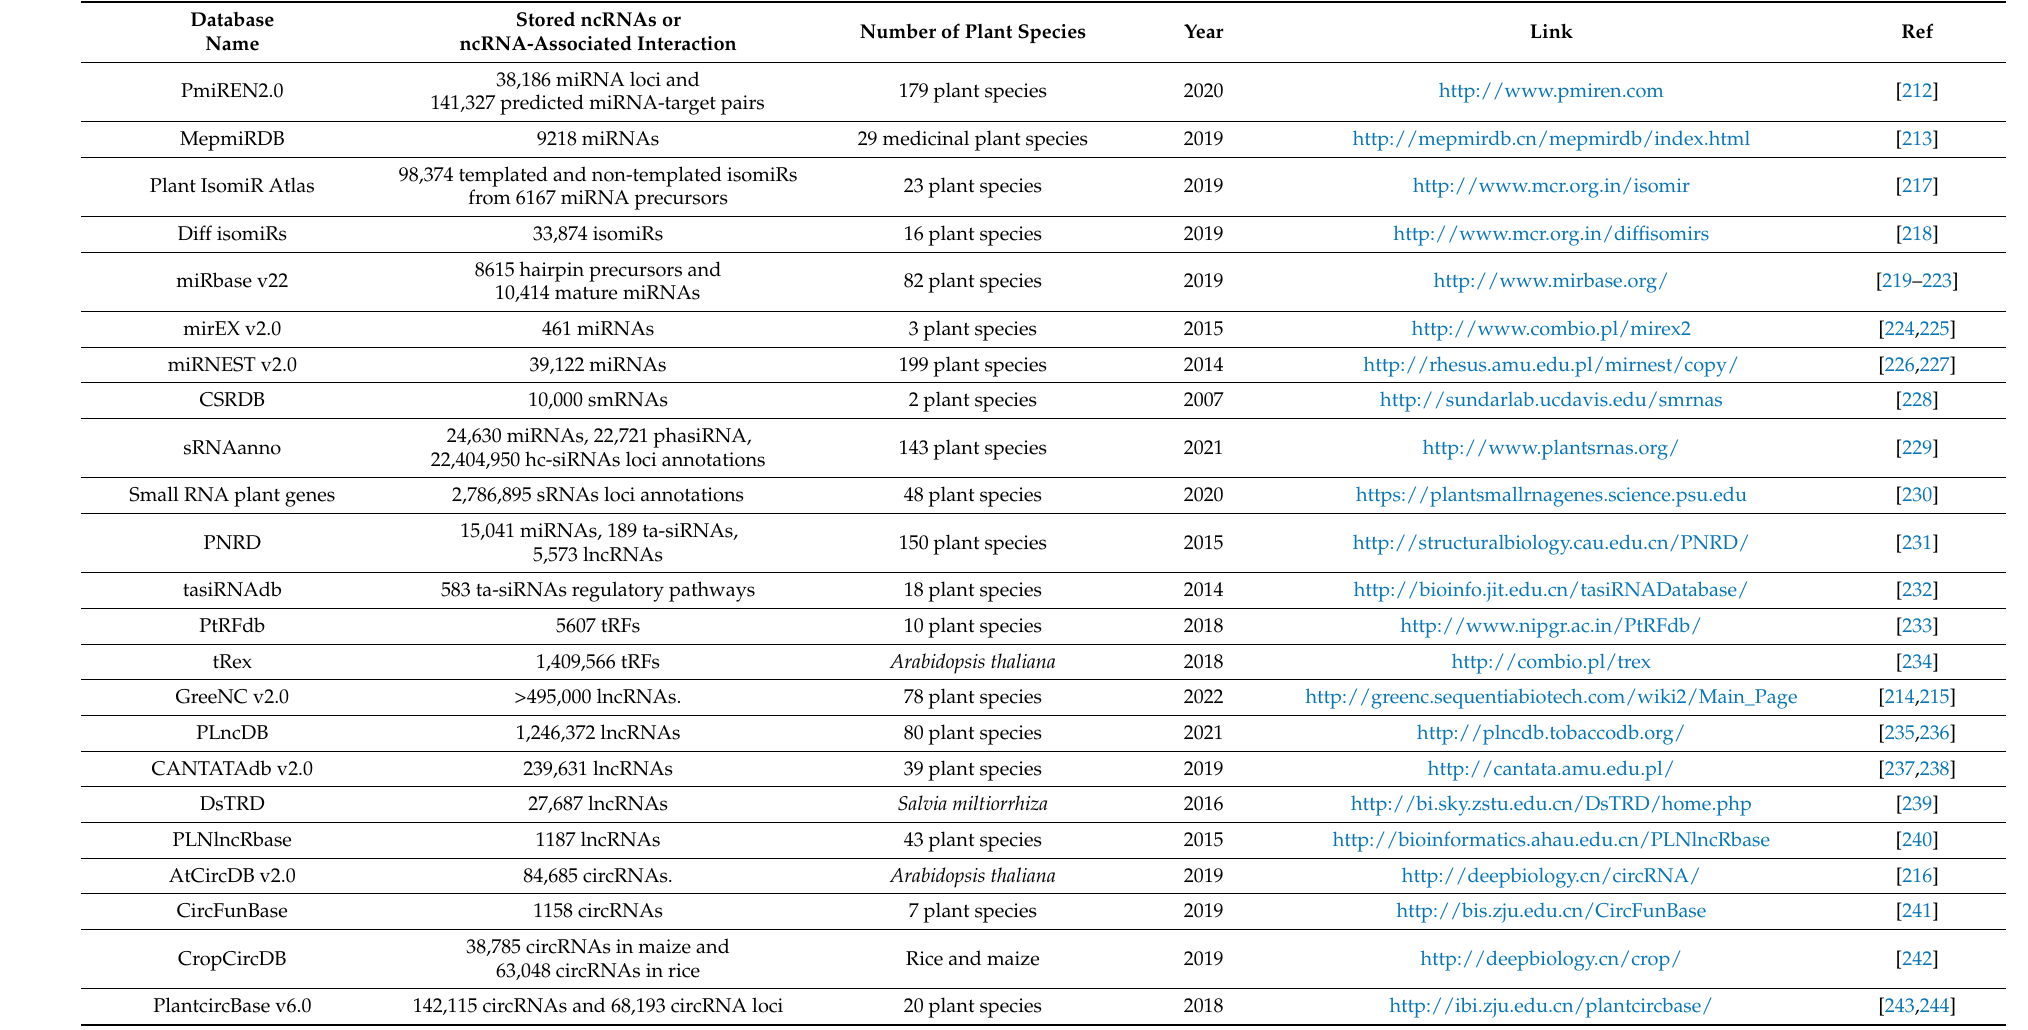
Table 2. List of ncRNA repositories and ncRNA interaction repositories in